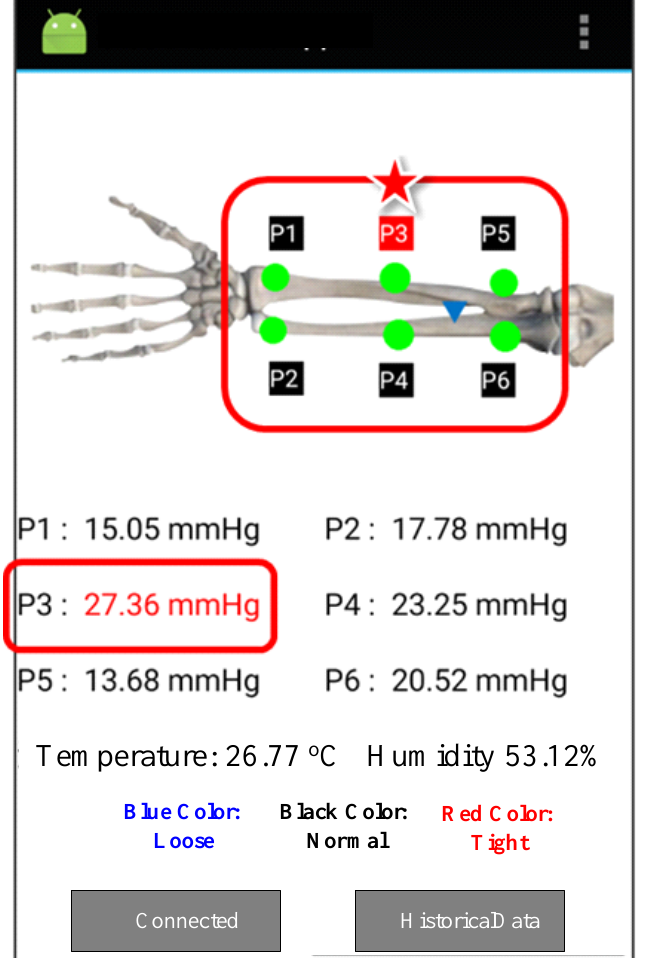
Figure 5. The screenshot of the mobile application when performing a short arm cast. The participants of the casting and splinting workshop are sixth-year medical